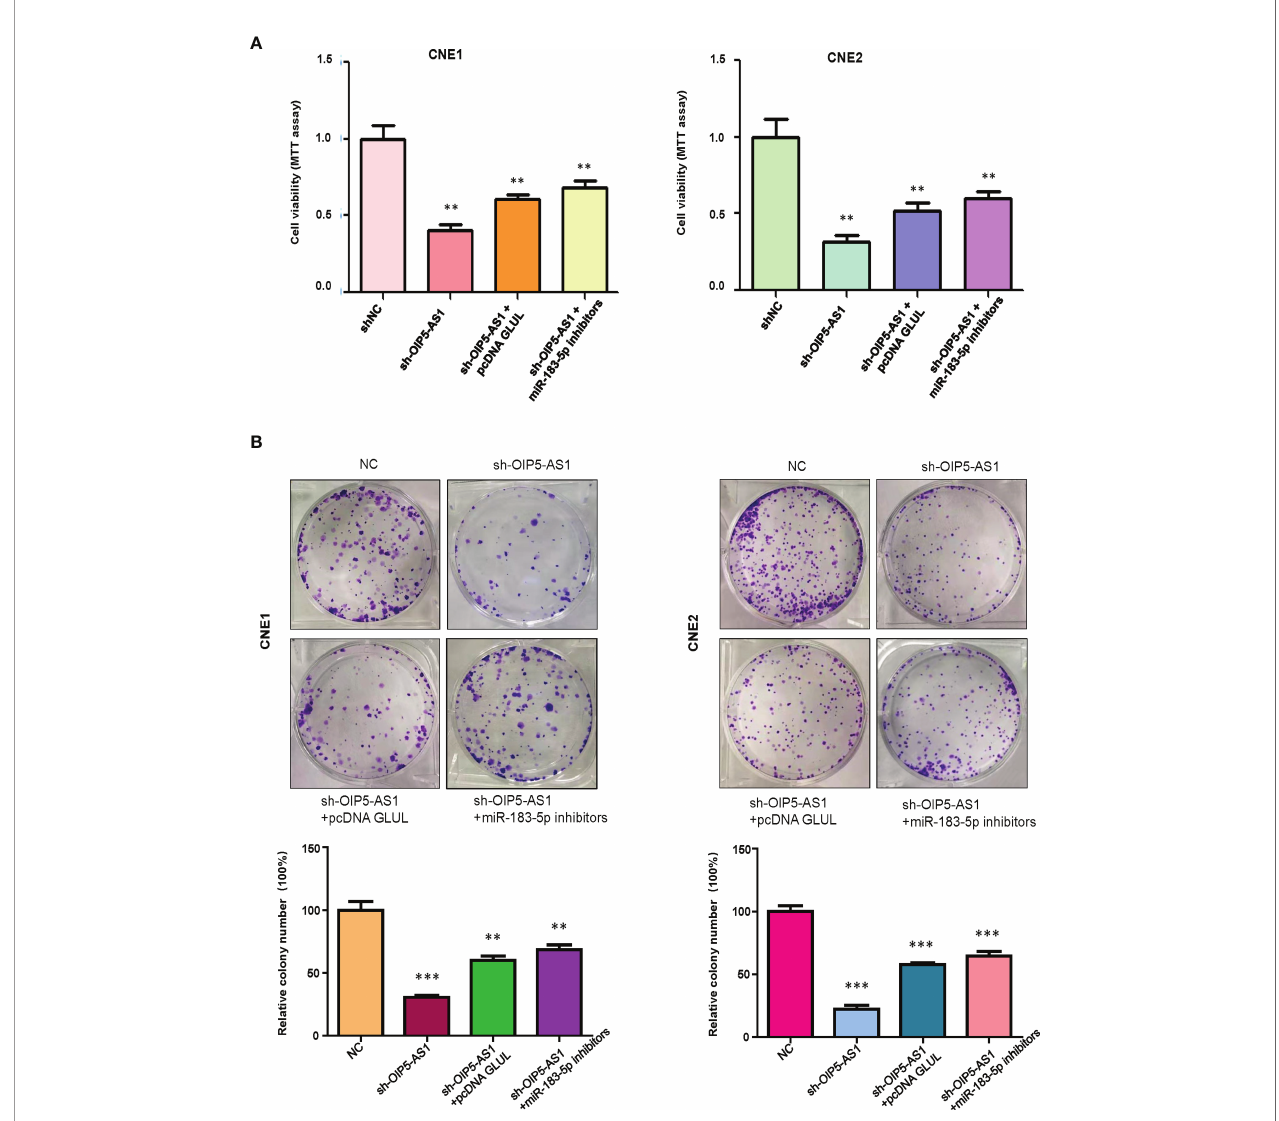
FIGURE 5 | OIP5-AS1 knockdown suppressed cell viability via regulating miR-183-5p in NPC cells. (A), MTT assay was used to measure the viability of NPC cells after OIP5-AS1 knockdown, GLUL overexpression and miR-183-5p downregulation. **P<0.01 vs control. (B), Cell colony formation was performed in NPC cells after OIP5- AS1 knockdown, GLUL overexpression and miR-183-5p downregulation (Top panel). Quantitative data are represented (Bottom panel). **P<0.01; ***P<0.001 vs